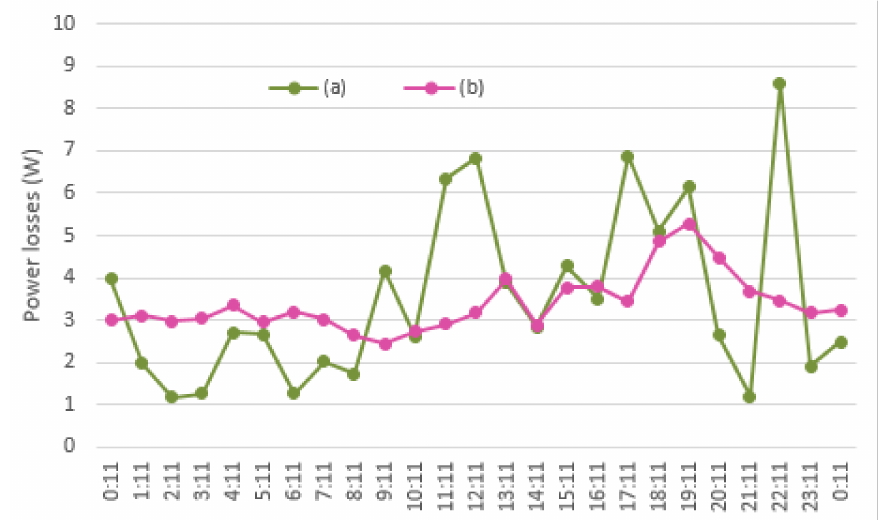
Figure 7. Transformer power losses in 24 h of a weekday caused by: ( a ) unbalanced currents ( P cu ) and ( b ) distorted currents ( P ch ).